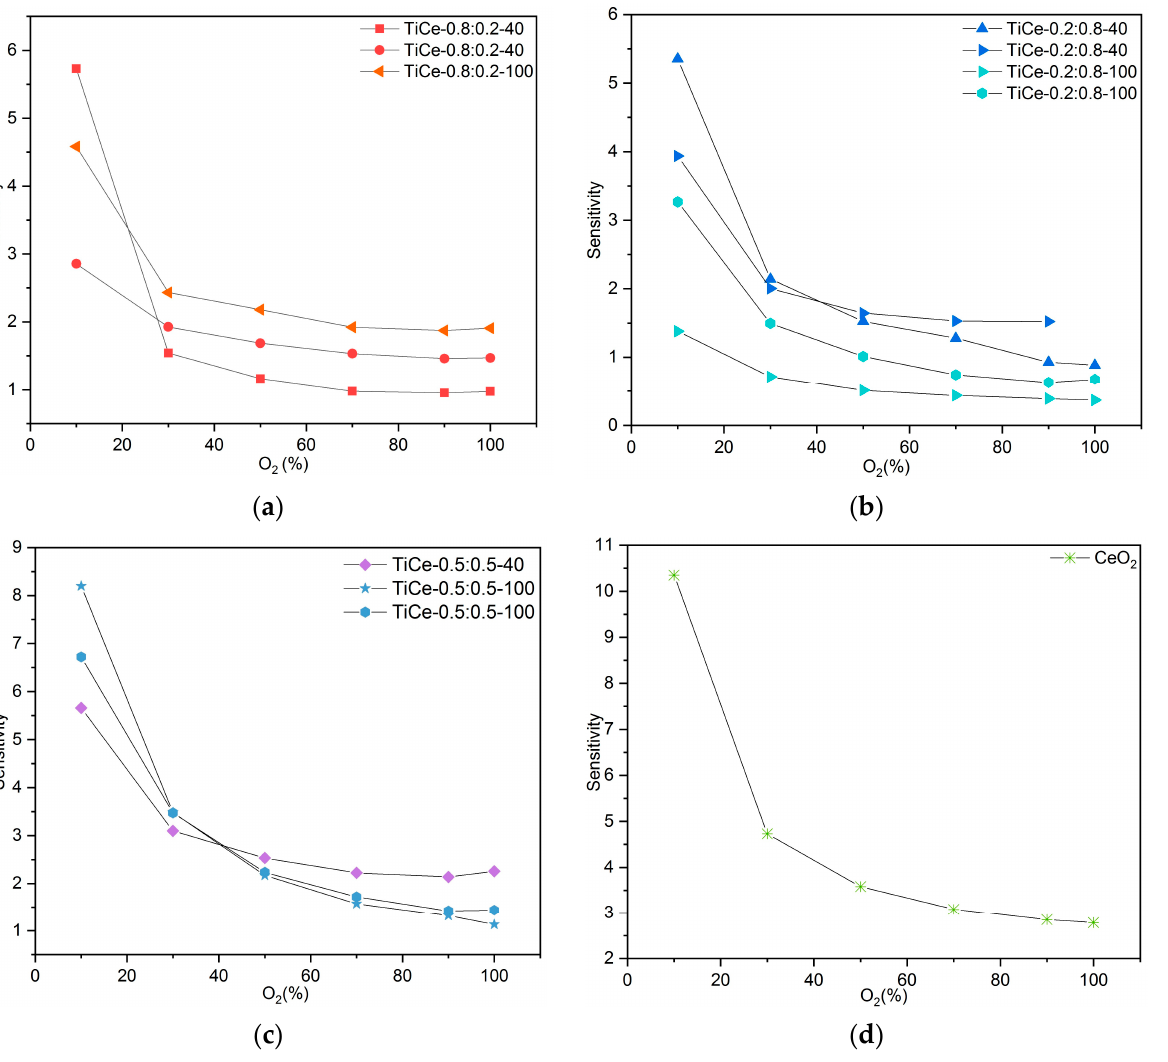
Figure 16. Obtained values for sensitivity of: ( a ) mixtures with ratio TiO 2 :CeO 2 =0.8:0.2; ( b ) mixtures with ratio TiO 2 :CeO 2 = 0.2:0.8; ( c ) mixtures with ratio TiO 2 :CeO 2 = 0.5:0.5; ( d ) CeO 2 .